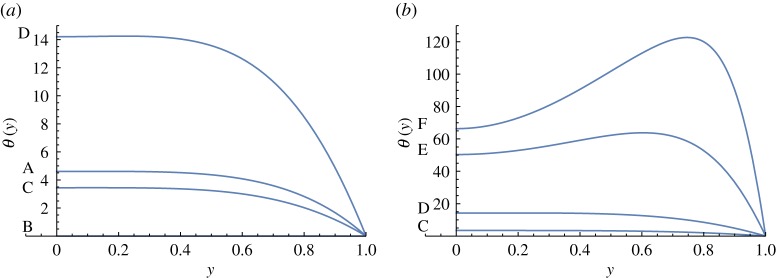
Temperature distributions when ε = 0.01 and r = 0.1.